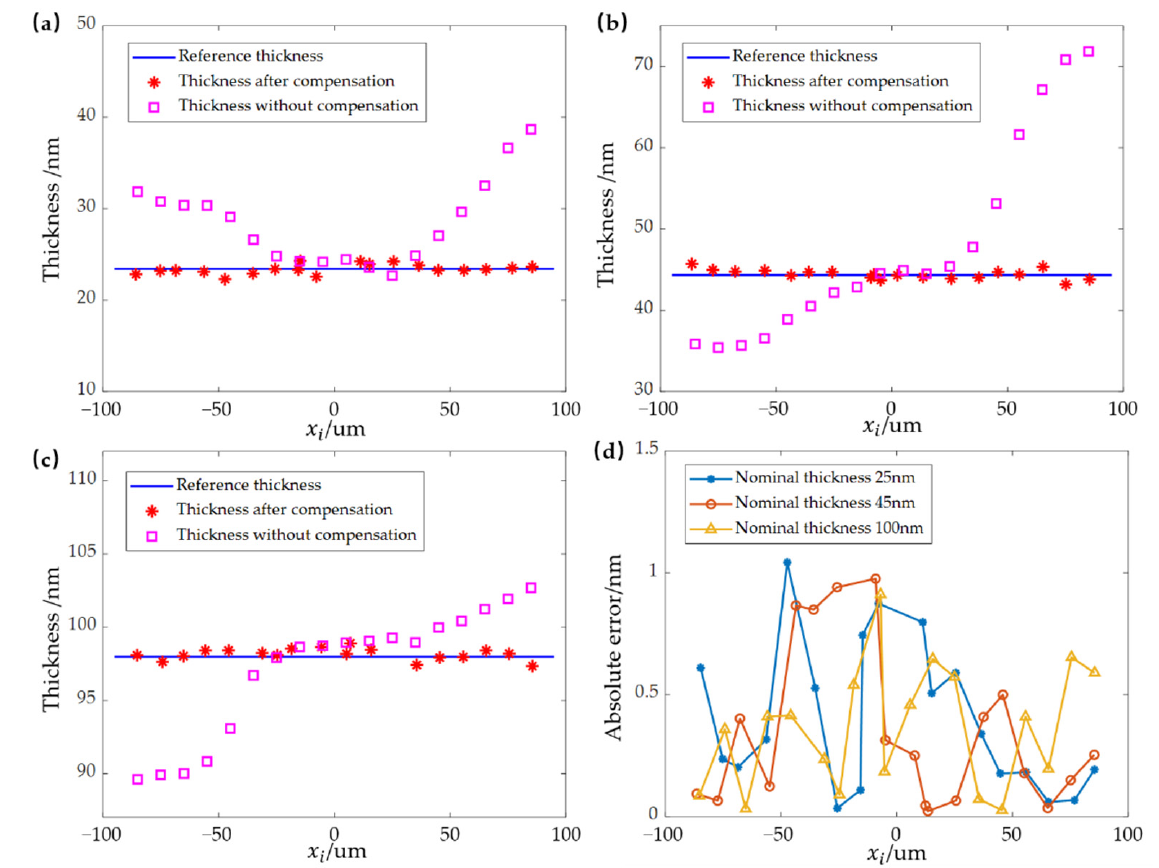
Figure 9. SiO 2 film thickness measurement experiments using the proposed method: ( a ) results of a film with nominal thickness of 25 nm; ( b ) results of a nominal thickness of 45 nm; ( c ) results of a nominal thickness of 100 nm; and ( d ) absolute thickness errors of the three thin films.